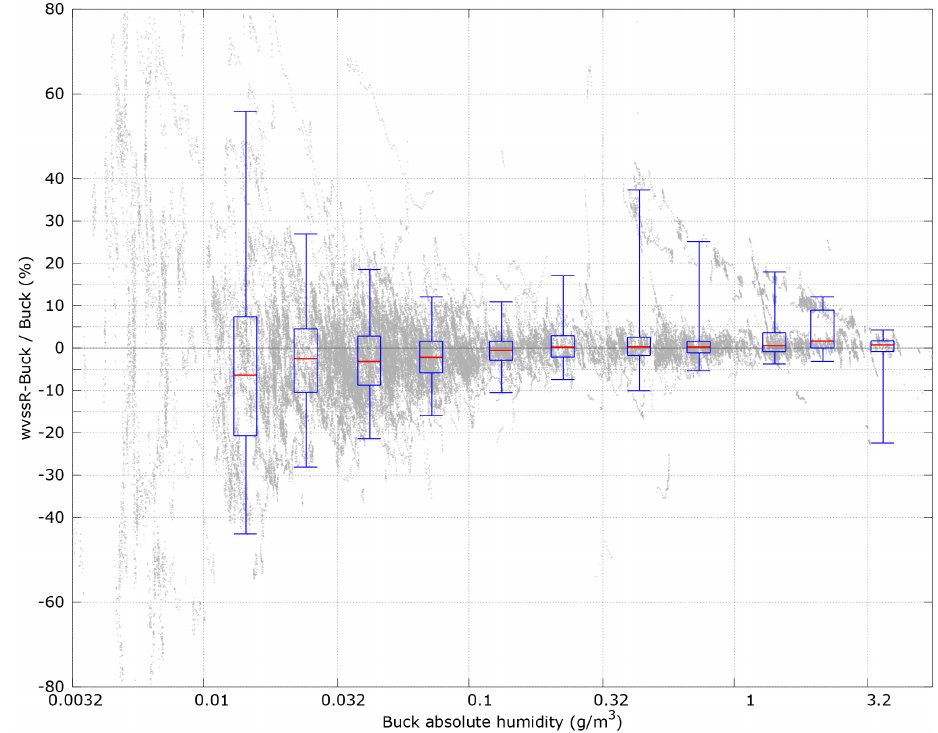
Figure 2. wvssR minus Buck in cloud free conditions. Boxes indicate binned quartiles, with the whiskers at 2nd and 98th percentiles.